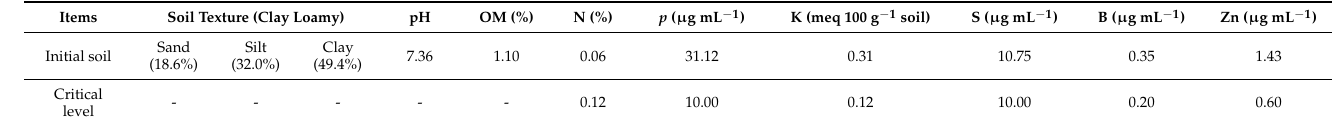
Table 3. Soil physical and chemical properties of the initial experimental soil.